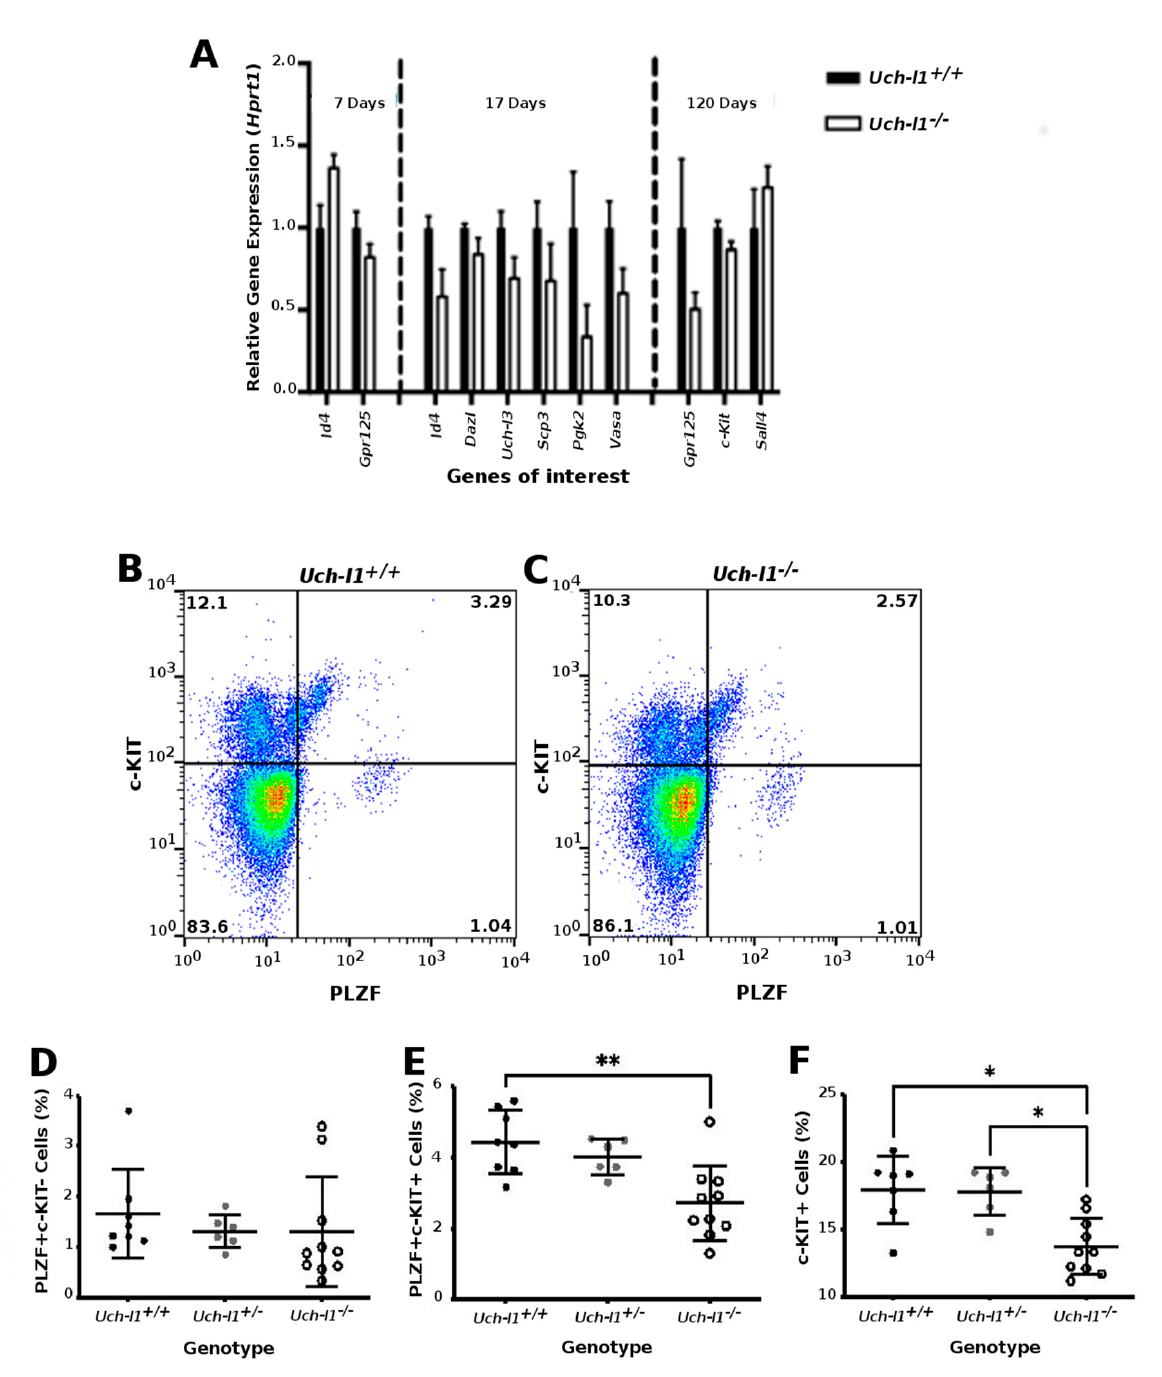
Figure 3. Analysis of whole Uch-l1 − / − , Uch-l1 + / − and Uch-l1 +/+ testes. ( A ) Quantitative PCR results of significantly differentially expressed genes in 7, 17 and 120-day old of Uch-l1 − / − relative to Uch-l1 +/+ testes ( B , F ) Flow cytometry analysis of PLZF and c-KIT positive cells in Uch-l1 +/+ , Uch-l1 + / − and Uch-l1 − / − testes at 120 days of age. n = 6/genotype. ( B , C ) Representative dot plot of c-KIT and PLZF positive cells in Uch-l1 +/+ and Uch-l1 − / − testes, respectively. ( D ) Percentage of PLZF+ c-KIT- cells in Uch-l1 +/+ , Uch-l1 + / − and Uch-l1 − / − . ( E ) Percentage of PLZF+ c-KIT+ cells in Uch-l1 +/+ , Uch-l1 + / − and Uch-l1 − / − . ( F ) Percentage of c-KIT+ cells in Uch-l1 +/+ , Uch-l1 + / − and Uch-l1 − / − . * indicates significant differences ( p < 0.05), ** represents significant differences p < 0.01.